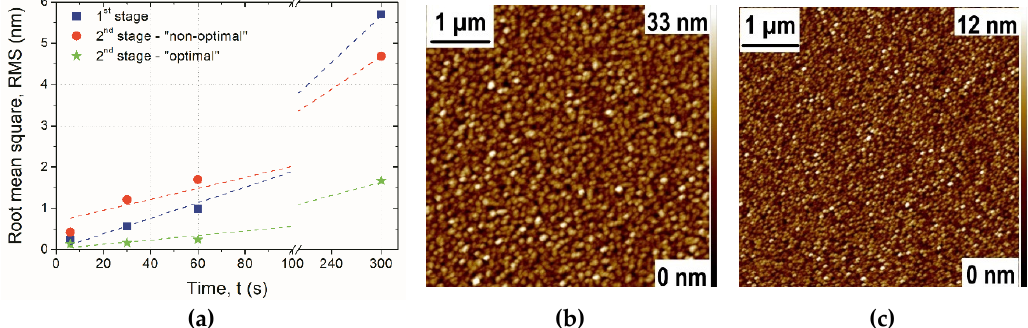
Figure 4. ( a ) Comparison of the roughness level of aluminum films fabricated using investigated sputtering procedures, and AFM micrographs of Al surface after formation using ( b ) ‘non-optimal’ (RMS = 4.8 nm), and ( c ) ‘optimal’ (RMS = 1.7 nm) recipe; sputtering time = 300 s.